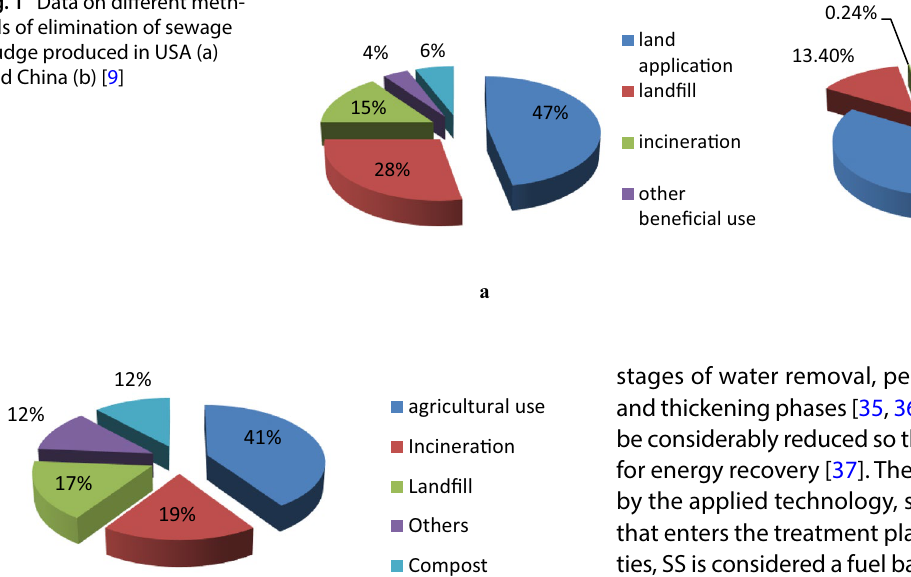
Fig. 1 Data on different meth- ods of elimination of sewage sludge produced in USA (a) and China (b) [9]